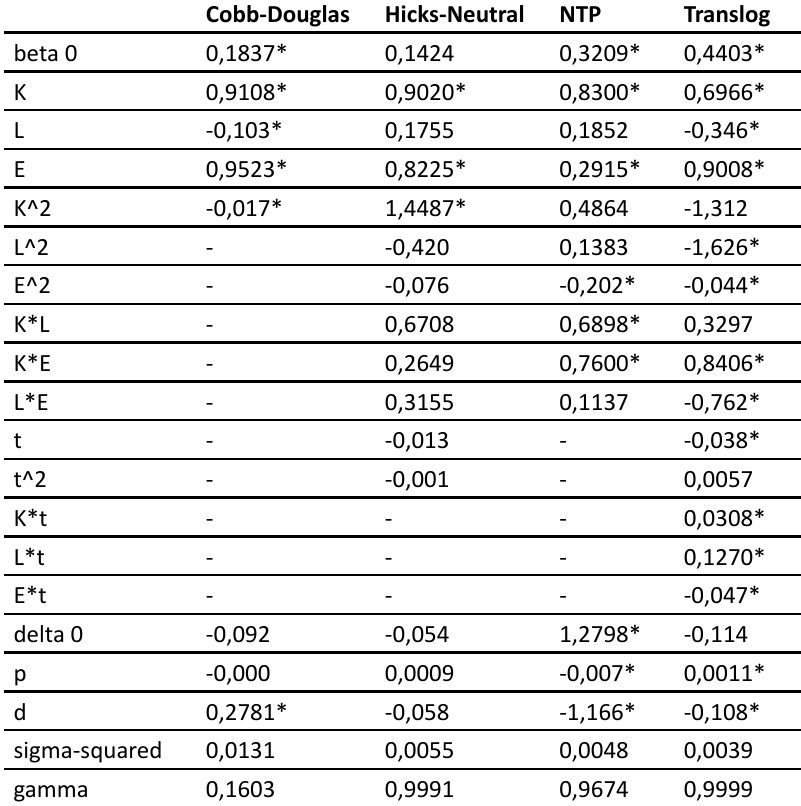
Table 2: The Estimated Coefficient of Inputs on Production Functions